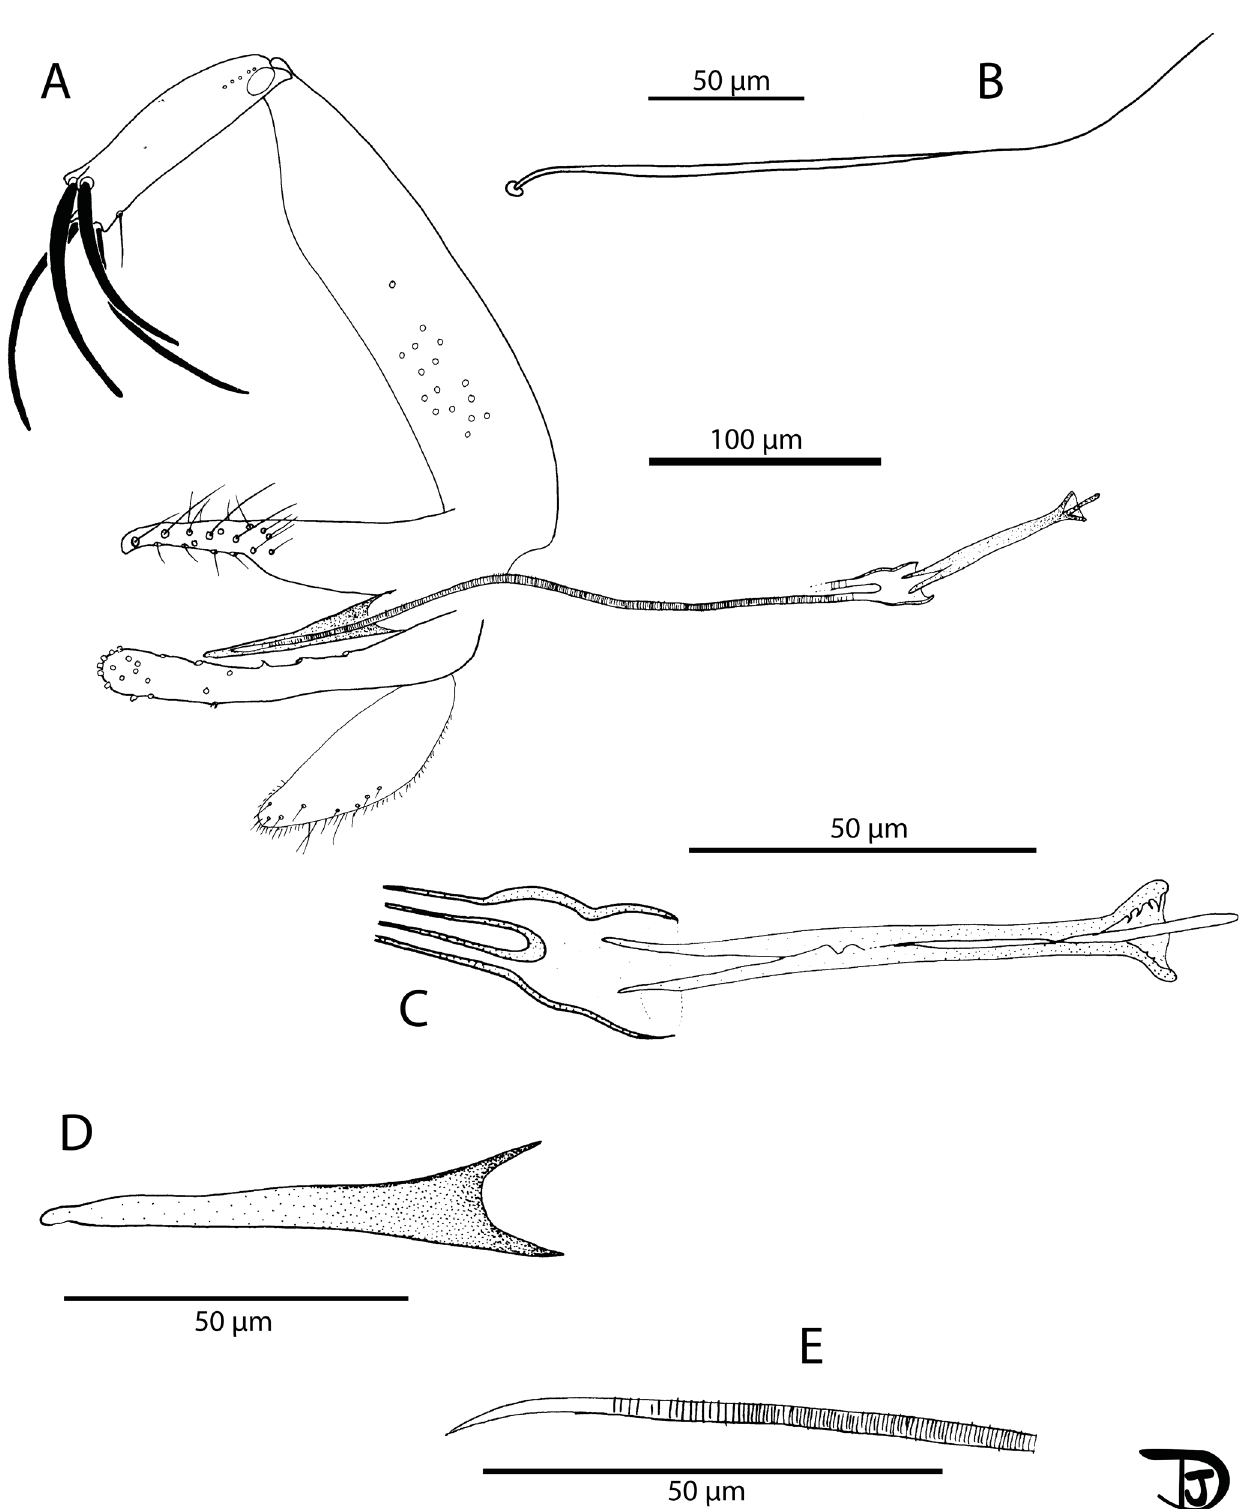
Figure 11. Sergentomyia (Ranavalonomyia) vol fi n. sp. male (paratype MADA825). (A) genitalia, (B) detail of a ventral coxal seta, (C) sperm pump, (D) parameral sheath, (E) top of the aedeagal